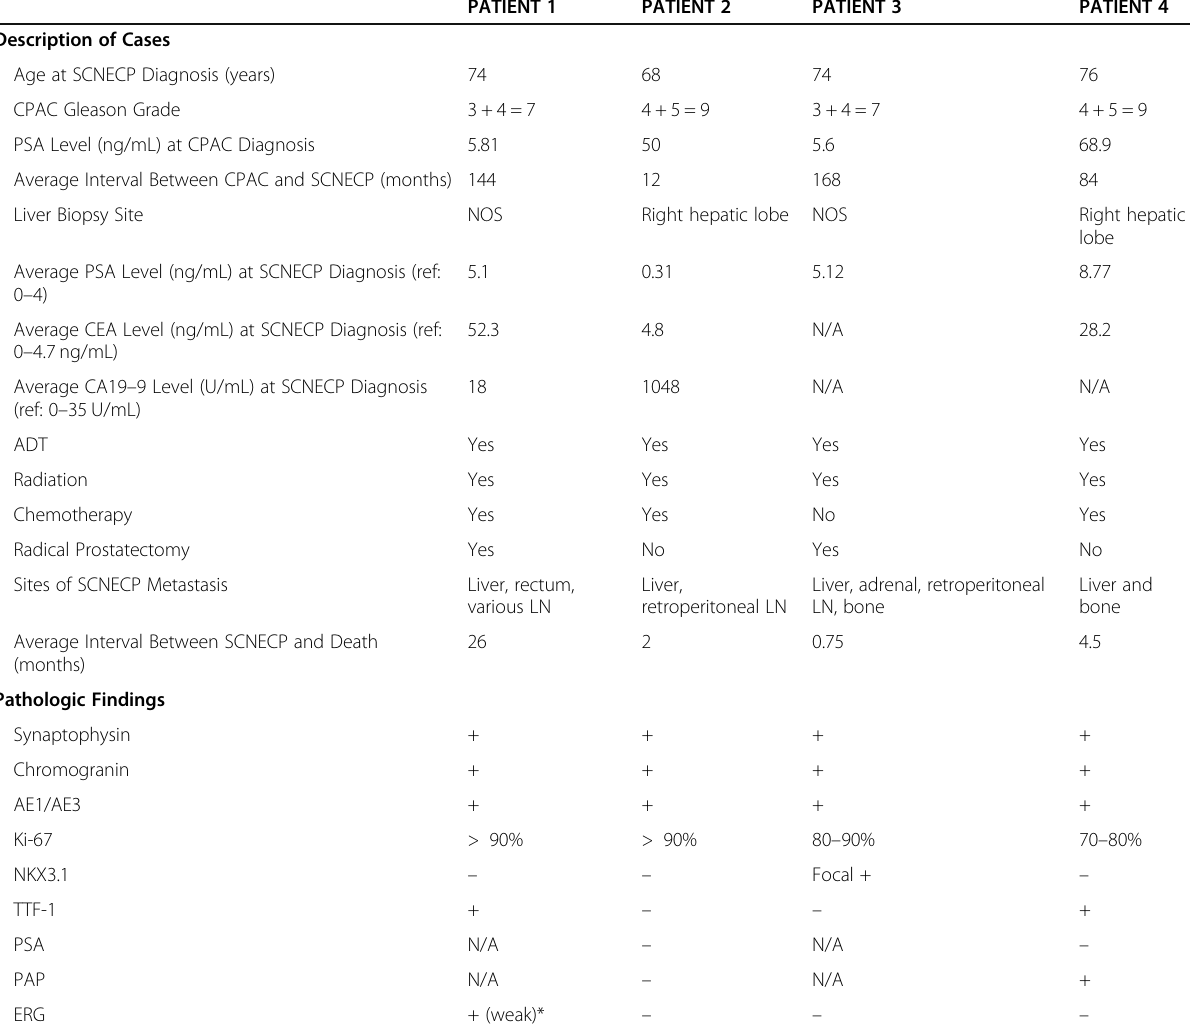
Table 1 Clinicopathologic features of metastatic small cell carcinoma of the prostate to the